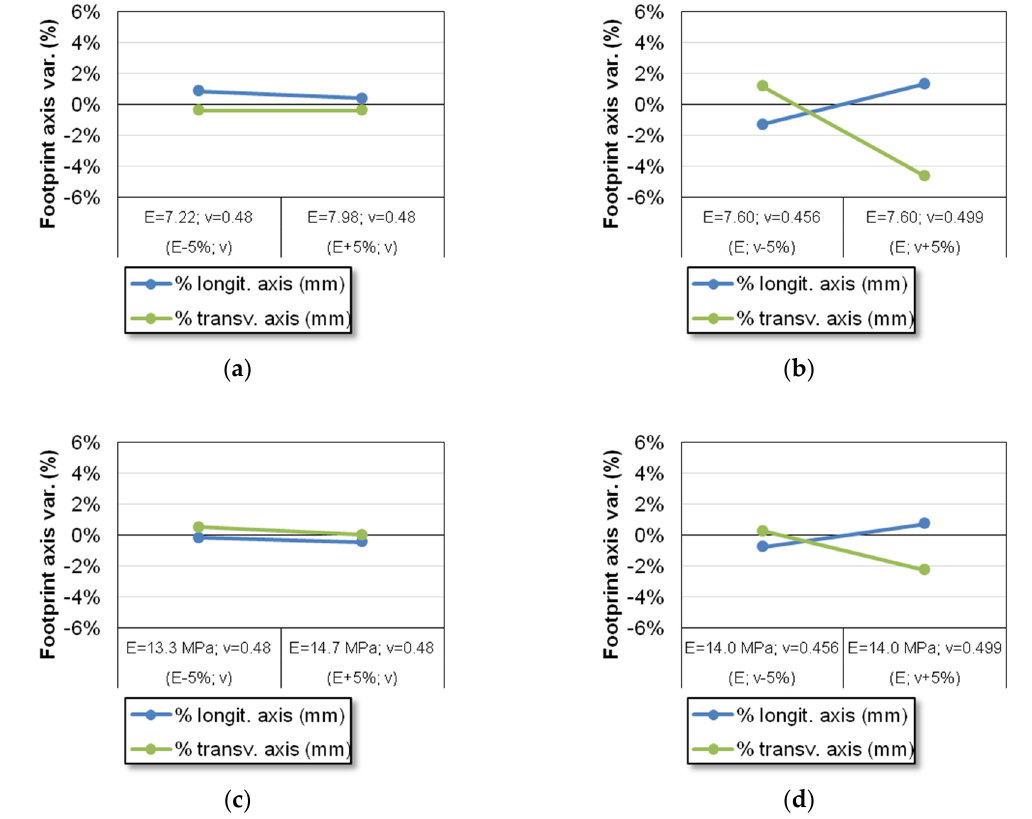
Figure 10. Longitudinal and transversal dimensions of the FEM footprint axis of the 420 / 85 R24 tyre with different equivalent Young’s moduli ( E ; column on the left) and Poisson’s ratios ( ν ; column on the right): ( a ) E ± 5%, inflation pressure of 1.0 bar; ( b ) ν ± 5%, inflation pressure of 1.0 bar; and of the 460 / 85 R34 ( c ) E ± 5%, inflation pressure of 1.0 bar; ( d ) ν ± 5%, inflation pressure of 1.0 bar.